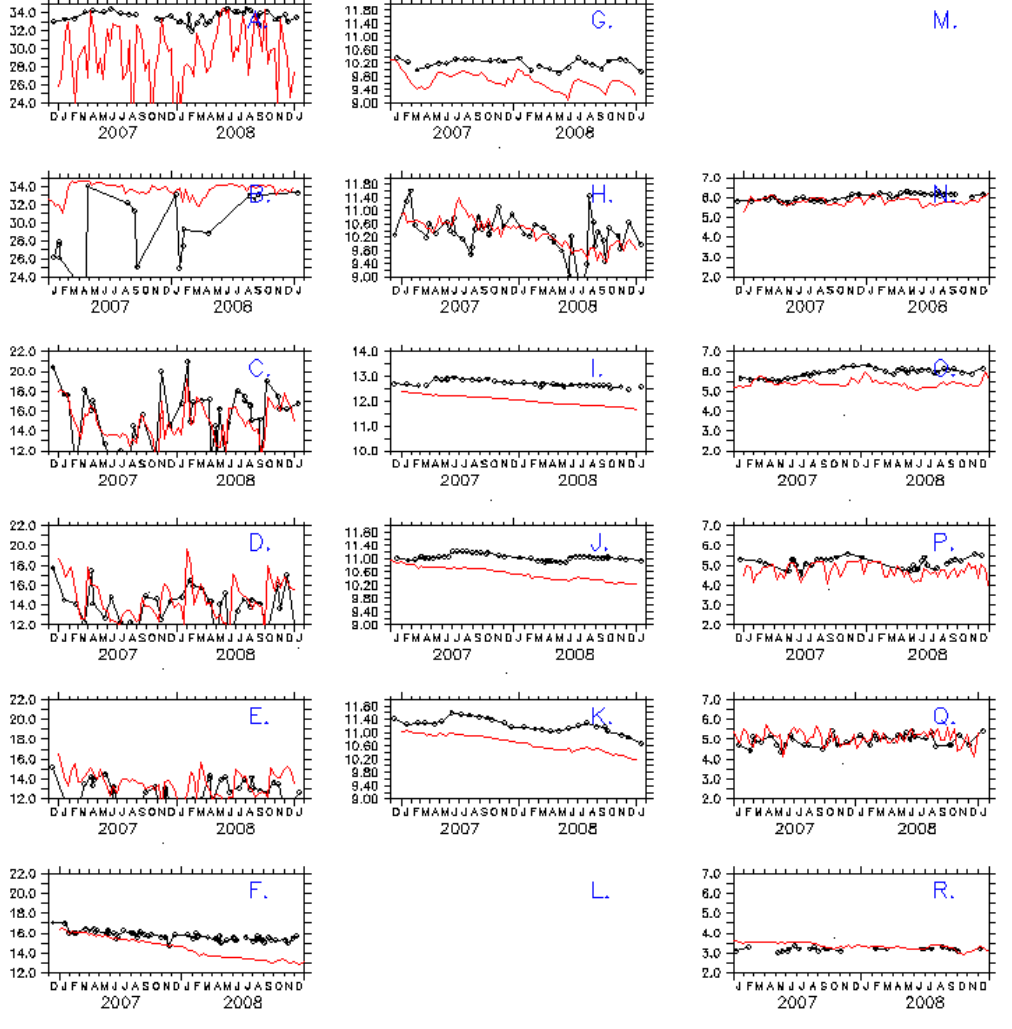
Fig. 5. Seasonal variability of salinity in bottom layer. Notations same as in Fig. 4. Table 4. Performance scores: scores are accorded to Nash and Sutcliffe (1970), OSPAR Commission (1998) and Allen et al. (2007). Surface layer All